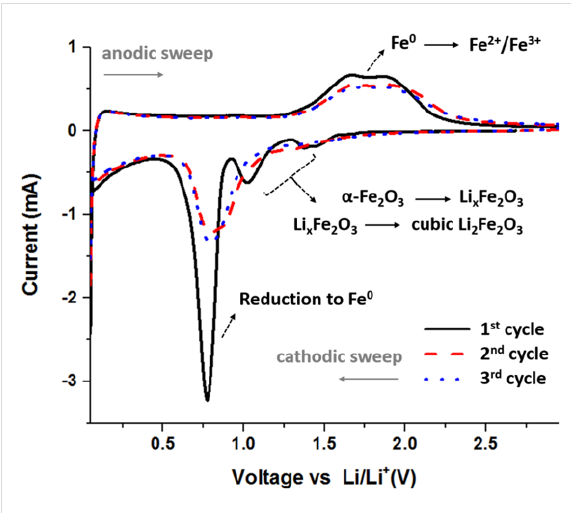
Figure 7: Cyclic voltamogramm profile of nanorod-shaped α -Fe 2 O 3 (obtained with a 1.5 M Fe 3+ concentration and ethylenediamine as the